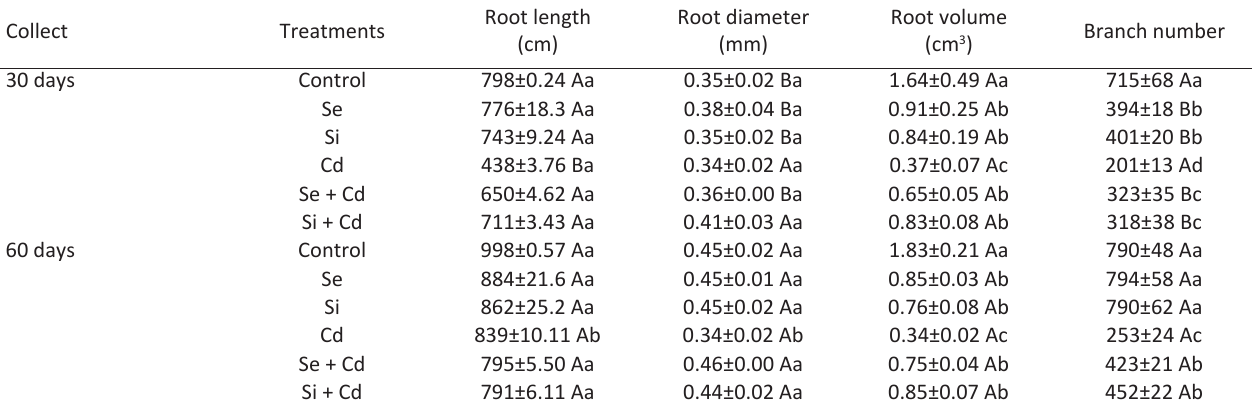
Different lowercase letters indicate significant differences between treatments in same collect. Different upper case letters indicate significant differences between collects for same